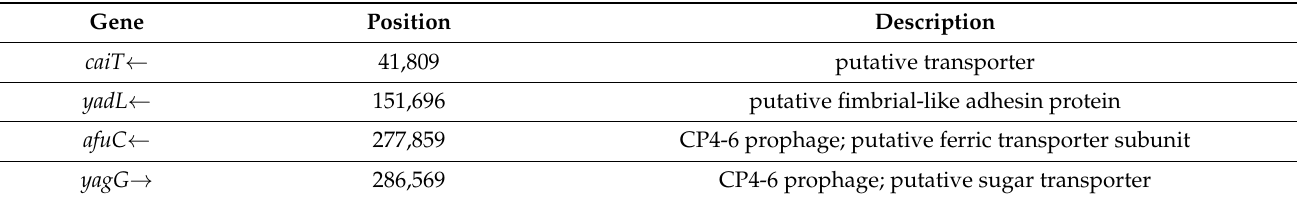
Table A6. Position and description of minor polymorphisms, control populations, day